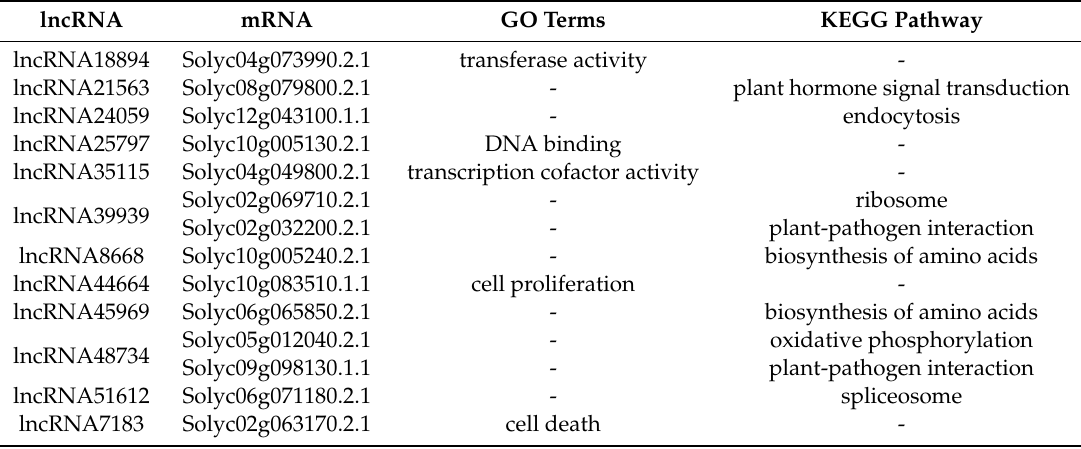
Table 2. GO terms and KEGG pathways for the target genes of selected 12